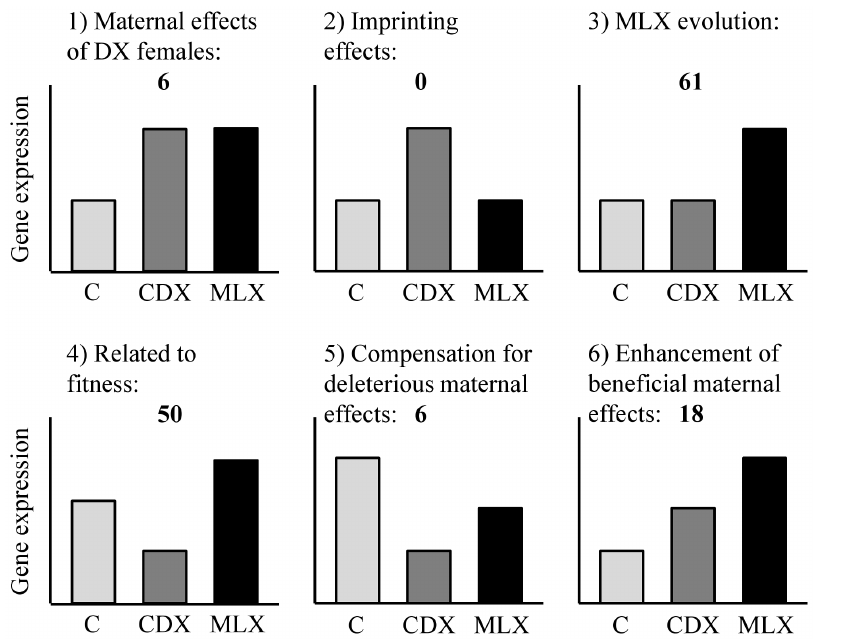
Figure 2. Graphical representation of transcript categories, and numbers of transcripts found in each category. Compare category 4 with Figure 3 (fitness results) and Figure S3 in file S1 (sex ratio results).